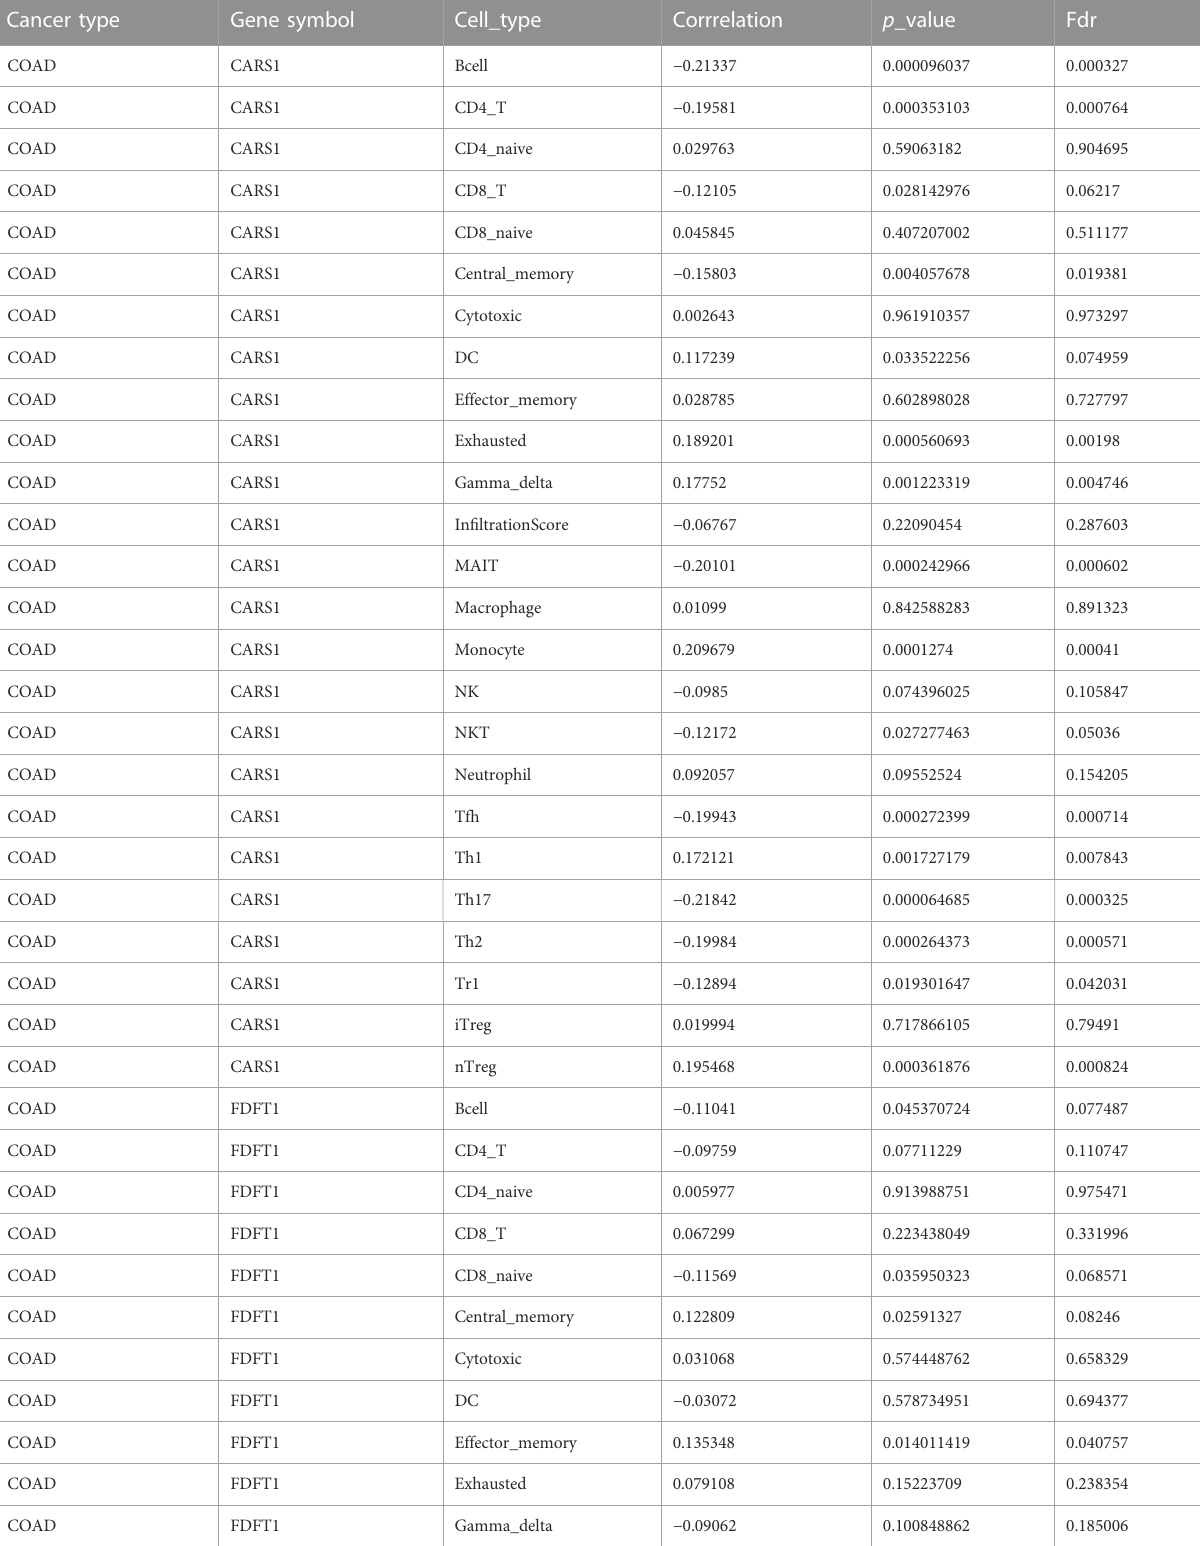
TABLE 2 FRGs and immune cell in fi